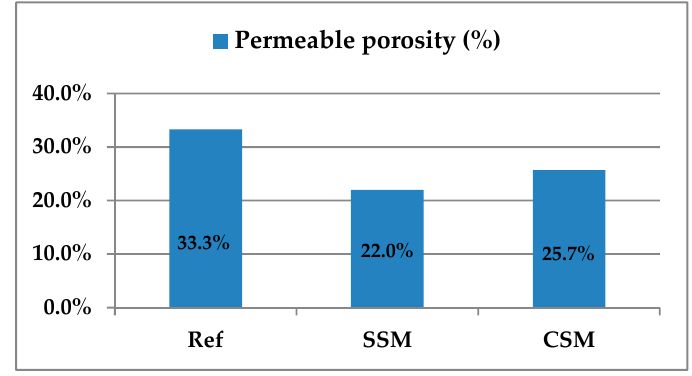
Figure 2. Permeable porosity (%) experimental results .